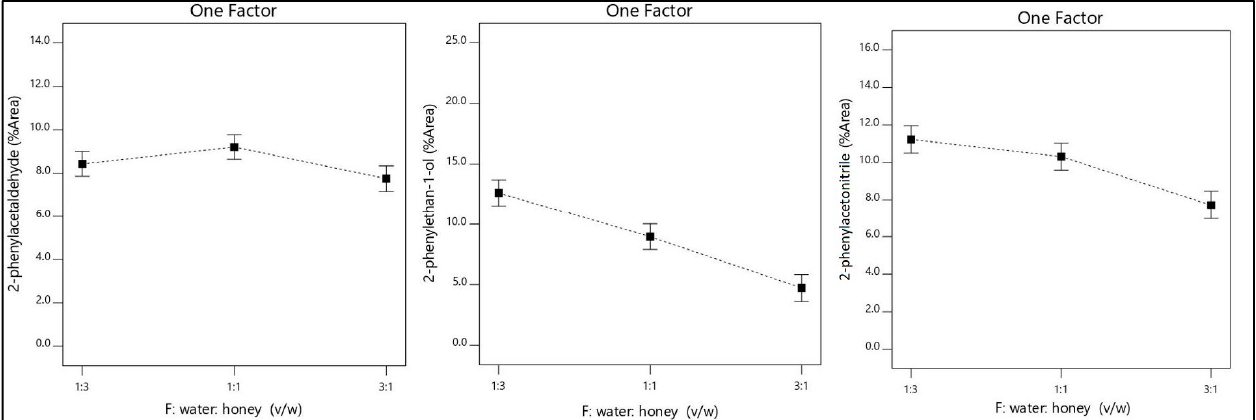
Figure 3. The ratio of water: honey ( v / w ) effect in the isolation of 2-phenylacetaldehyde, 2-phenylethan-1-ol, and 2-phenylacetonitrile.